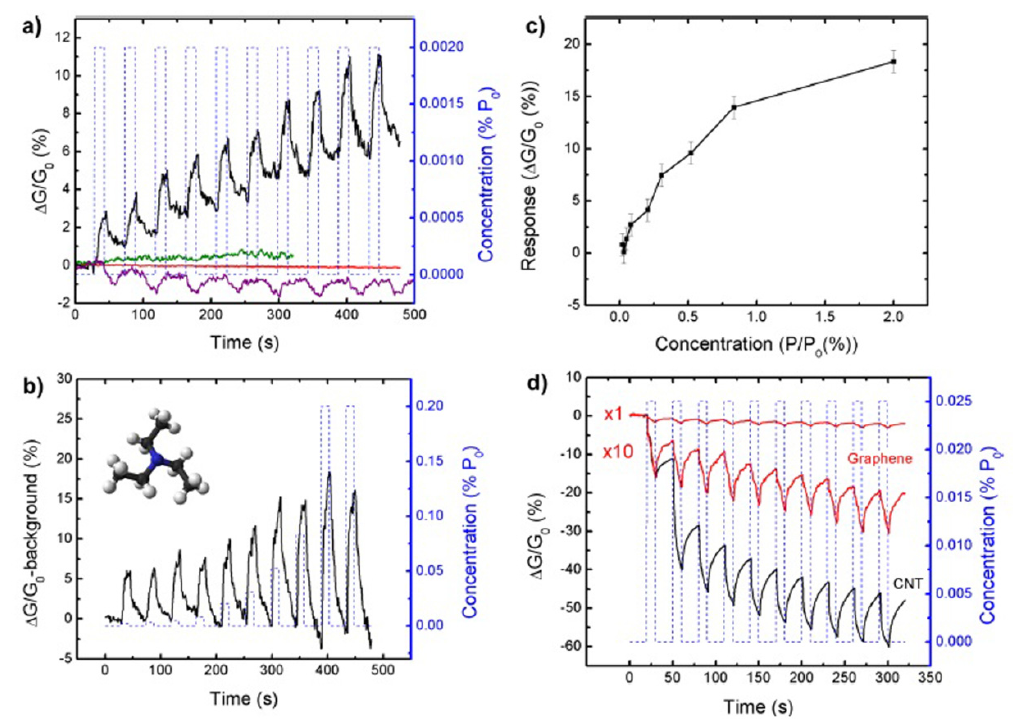
Figure 9. Response of sensors to triethylamine (TEA) exposure. ( a ) Change in conductivity of the monolayer MoS 2 sensor channel upon exposure to a sequence of 0.002% P 0 TEA pulses (black line). The dashed blue lines show the pulse timing (15 s on/ 30 s off) and concentration. The solid red line shows the response to exposure of nitrogen only and serves as a control experiment. The solid green and purple lines show the response of the MoS 2 and graphene sensors to water vapor pulses (0.025% P 0 ), respectively; ( b ) Same as part a, but for a series of exposure pulses in which the TEA concentration increases from 0.002% P 0 to 0.2% P 0 . A positive slope background has been removed. The inset shows a model of the TEA molecule, in which the nitrogen atom is blue, the carbon atoms are black, and the hydrogen atoms are light gray; ( c ) The amplitude of the conductivity change increases with TEA concentration. The vertical axis is the response to each individual pulse (not the time integrated response); ( d ) Change in conductivity of a CVD graphene monolayer (red) and CNT-network sensor (black) upon exposure to a sequence of 0.025% P 0 TEA pulses (10 s on/20 s off). Reprinted with permission from Ref. [83]. Copyright, 2013, American Chemical